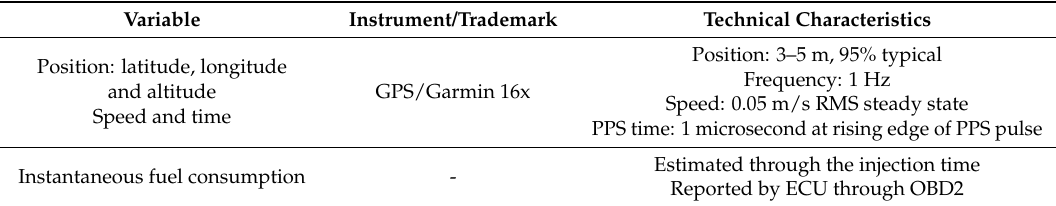
Table 2. Technical characteristics of the instruments used in this